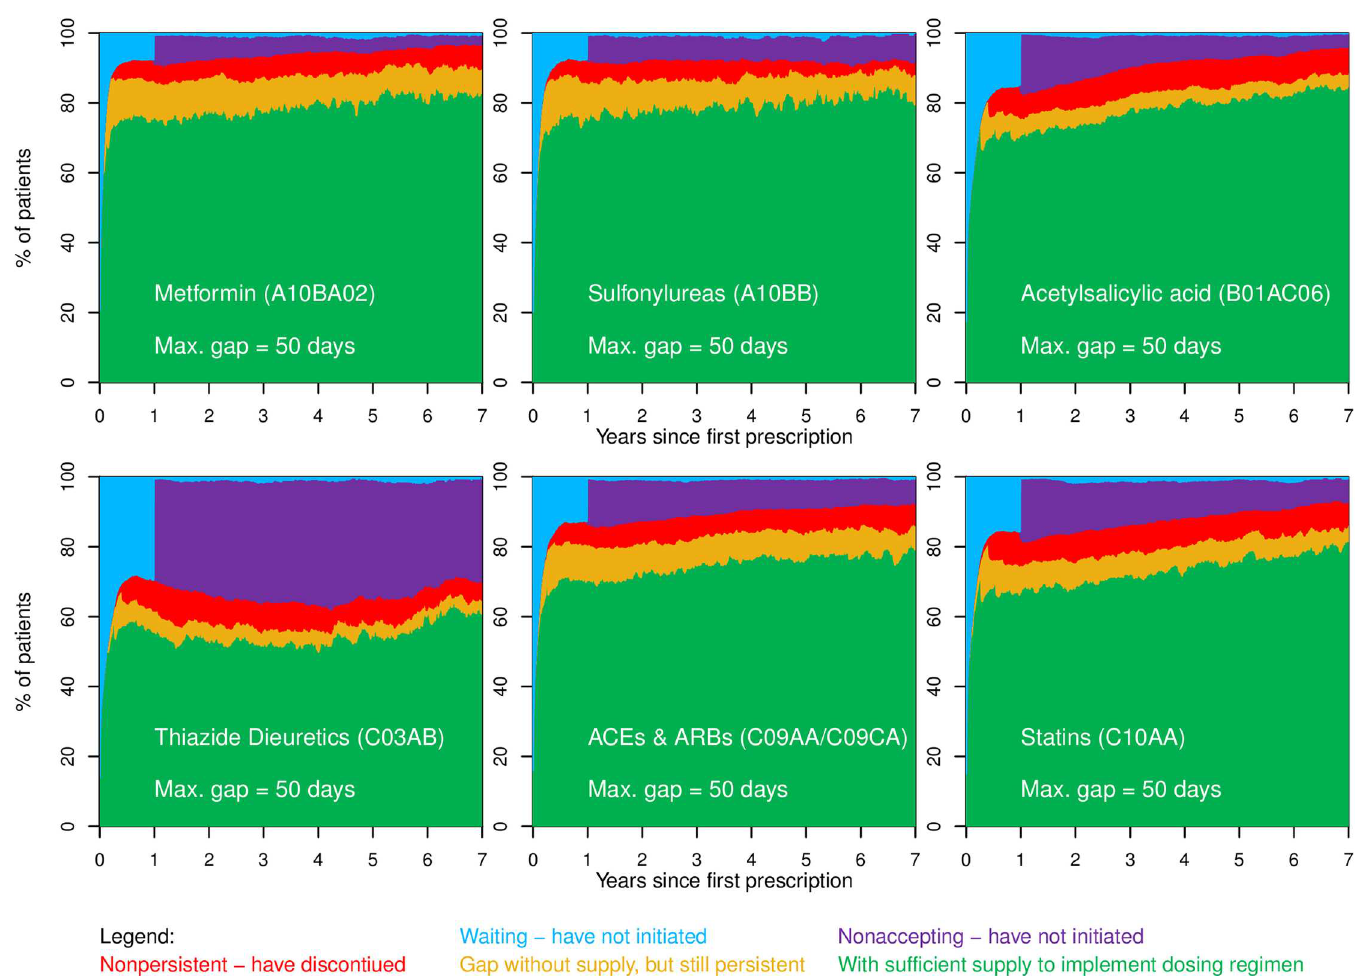
Fig 1. Time course of adherence to metformin, sulfonylureas, acetylsalicylic acid, thiazide diuretics, ACEs & ARBs, and statins. Patients are categorized in one of five different states duringfollow-up: Waiting and not having initiatedtreatment yet is represented by the blue area in the figure; having filled prescriptions and having sufficient supply of medicationto cover the daily prescribed dose (green area); being without suppliesfor a maximum of 50 days (yellowarea); having discontinued treatment after a gap of 50 days without suppliesof medication(red area), whereasthe purplearea represents patients who do not initiate treatment by filling a prescriptionwithin the first 360 days and hencehave not accepted the treatment. Patients will move between the 5 states duringfollow-upaccordingto their adherencebehavior. The proportionof patients in each of the 5 states at any given time is shown on the vertical axis. Further detailsare describedby Jensen et